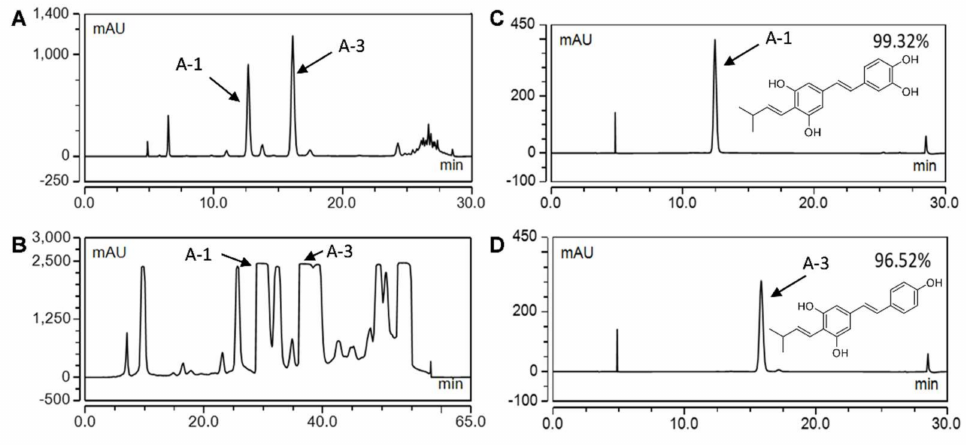
Figure 1. HPLC chromatograms (UV 340 nm) of extracts and purified prenylated stilbenoids from the medium of elicited peanut hairy root cultures. ( A ) Analytical HPLC chromatogram of extract from the culture medium showing arachidin-1 (A-1) and arachidin-3 (A-3). ( B ) Semi-preparative HPLC chromatogram of extract from the culture medium. ( C ) Purified A-1 and chemical structure. ( D ) Purified A-3 and chemical